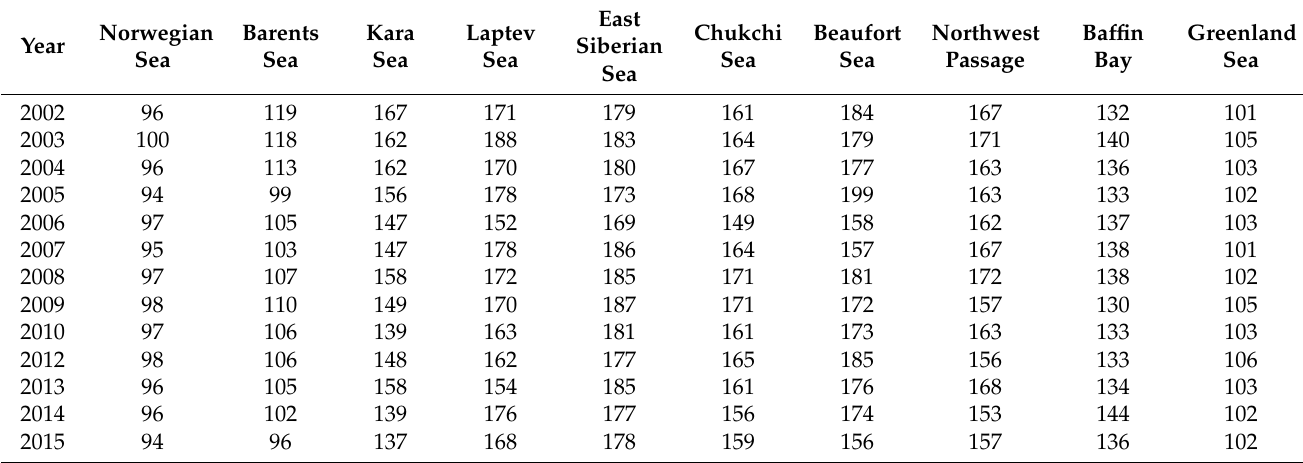
Table 4. DoY of Arctic sea ice break-up from 2002 to